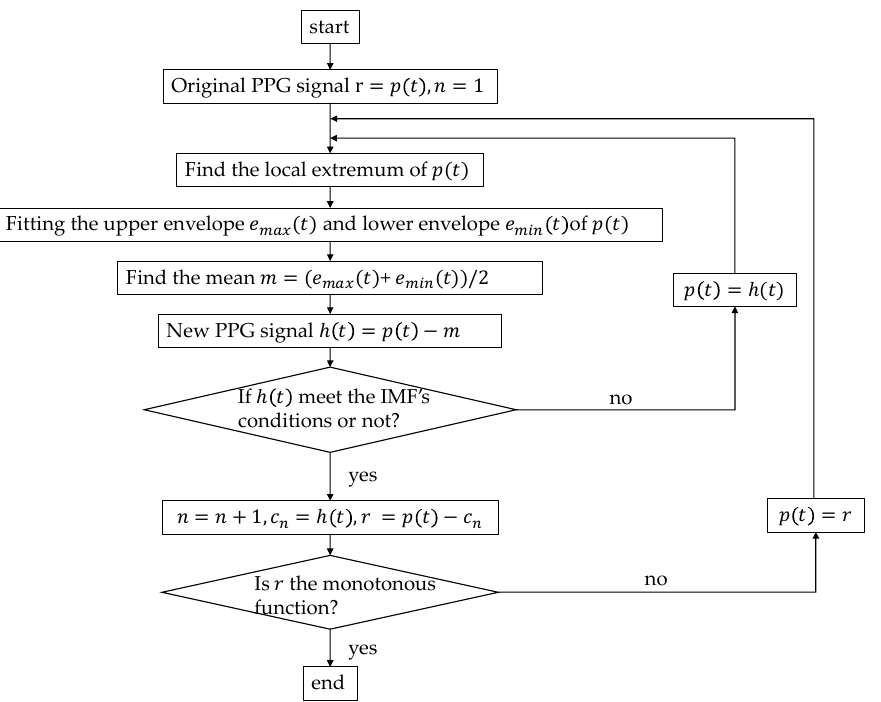
Figure 2. EMD (empirical mode decomposition) processing algorithm. IMF (intrinsic mode function) conditions: (1) In the entire time range, the number of local extreme points and zero points of the function must be the same or differ by one at most. (2) At any point in time, the average value of the envelope of the local maximum of the function (upper envelope) and the envelope of the local minimum (lower envelope) must be